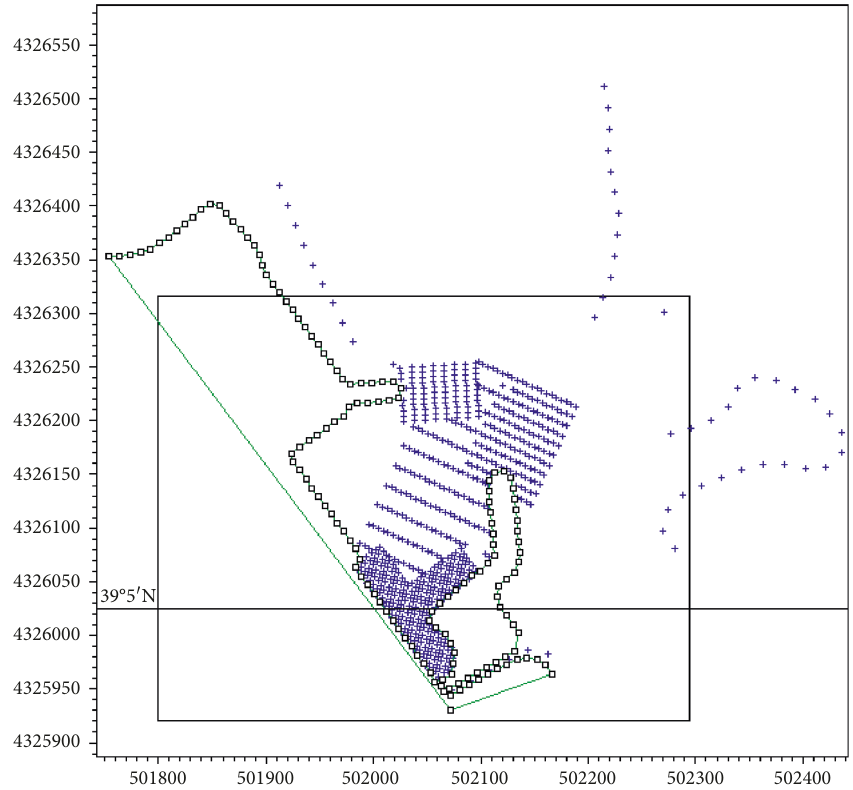
Figure 8: Single beam survey at the Saras